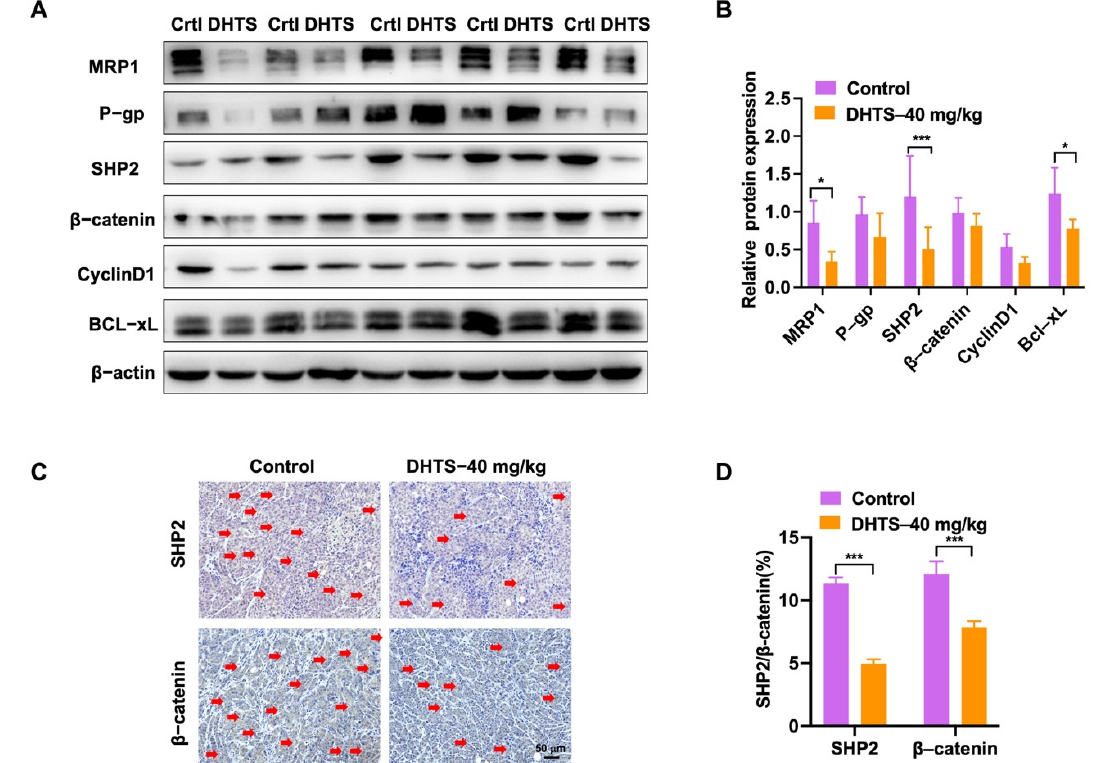
Figure 8. DHTS reduces the expression of drug resistance, apoptosis-related proteins, SHP2, and Wnt/ β -catenin in tumor tissues between the control group and DHTS group. ( A , B ) Protein expression and data statistics of MRP1, P-gp, SHP2, β -catenin, Cyclin D1, and Bcl-xL by western blot; ( C , D ) representative images of IHC staining and data statistics of SHP2 and β -catenin (compared to the control group, * p < 0.05, *** p < 0.001). The red arrow indicates positive for SHP2 and β - Catenin staining.